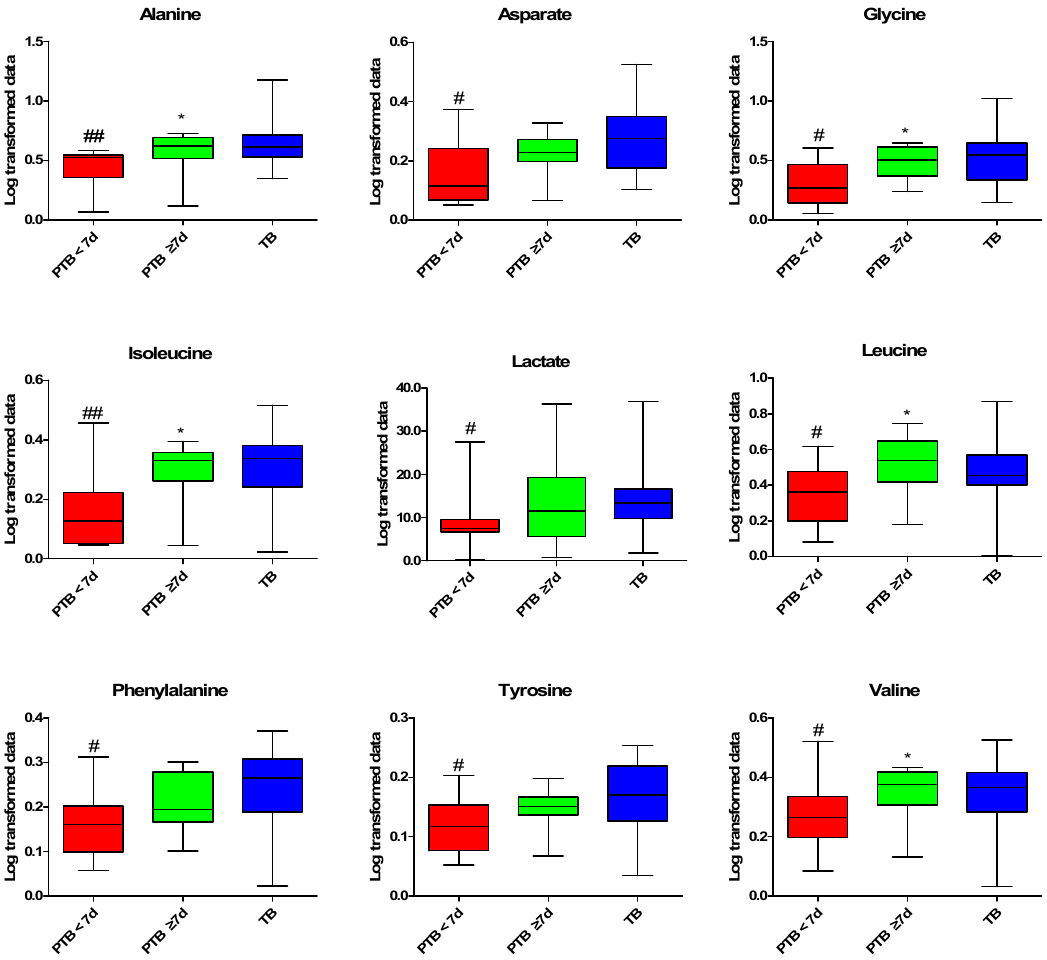
Figure 3. Decreased metabolites profiling in CVF. Kruskal–Wallis test was used for the statistical analysis. The PQN Log-transformed data were used for graphical representation Data are presented as the ± standard deviation, and p < 0.05 considered as significant. #: PTB < 7 d vs. TB, *: PTB < 7 d vs. PTB ≥ 7 d. # p < 0.05, ## p < 0.01, * p < 005. PTB: preterm birth; PTB < 7 d: preterm birth less than 7 days